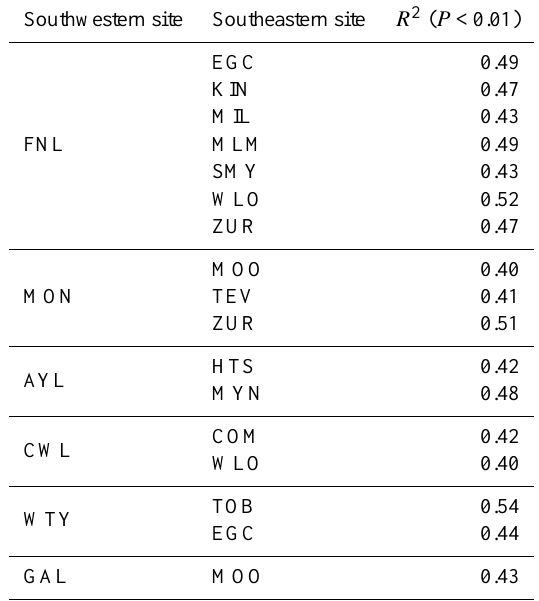
Table 1. Negative correlation between each pair of the sites. Southwestern site Southeastern